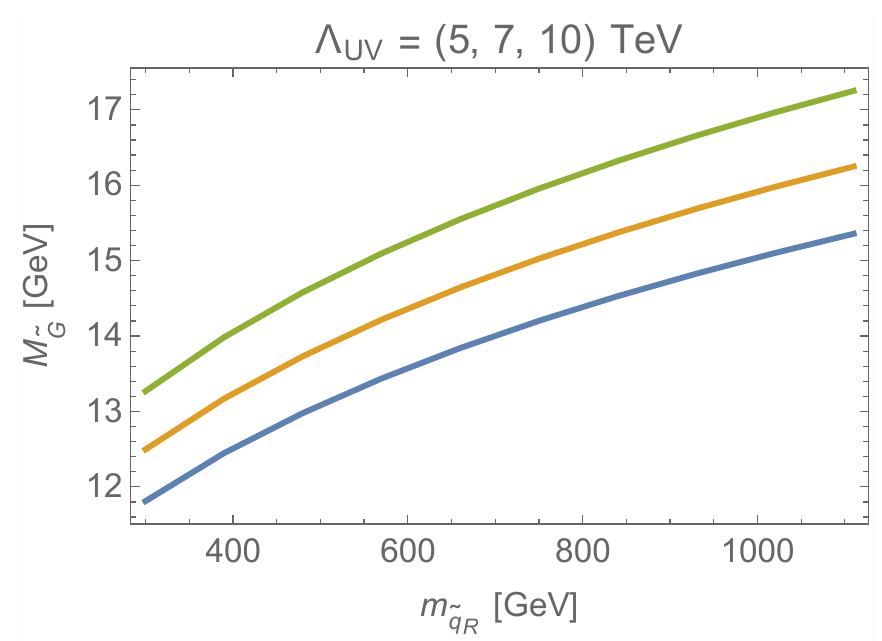
Figure 2 . 0 ++ glueball mass as a function of the right-handed f-squark mass, for (from bottom to top) (cid:3) UV = 5 ; 7 ; 10